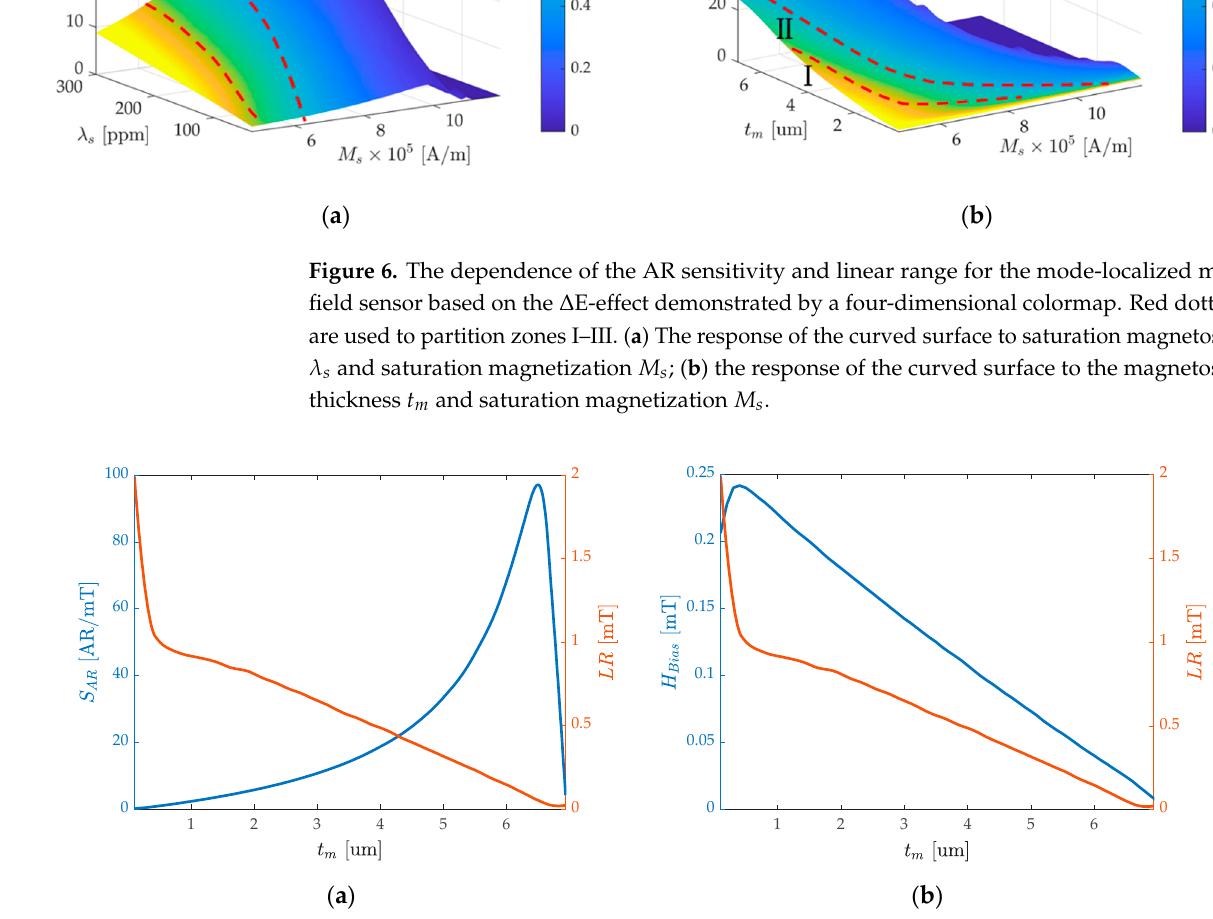
Figure 7. Selecting the projection surface of the saturation magnetization M s = 0.75/ µ 0 from Figure 6b: ( a ) the dependence of the AR sensitivity and linear range on the magnetostrictive film thickness t m ; ( b ) the dependence of the biased magnetic field and the linear range on the t m